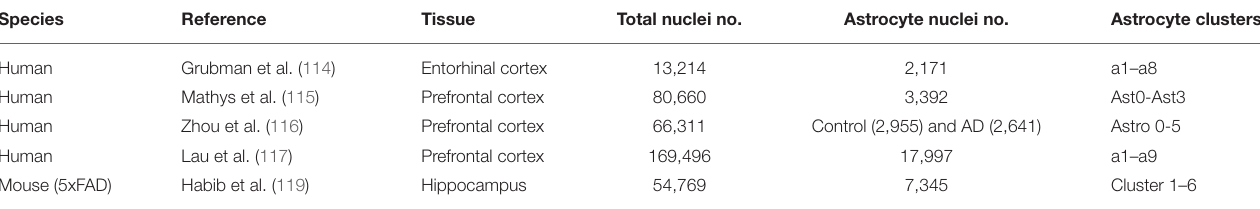
TABLE 1 | Example studies of astrocyte heterogenity in AD.